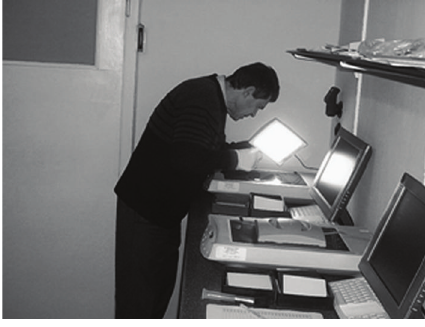
Figure 11: Plate scanning e ff orts at the Sonneberg Observatory, the largest European plate collection (280000 plates). More than 200000 plates were digitized